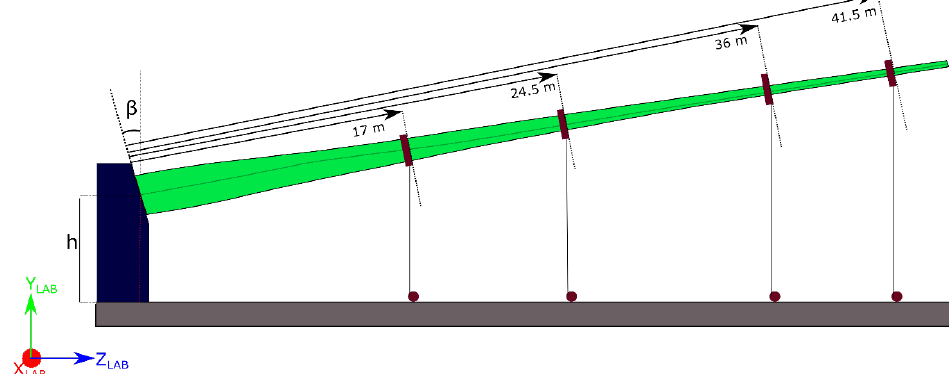
Figure 1. Schematic overview of the static test setup. The blade was positioned onto the reaction block at a height (h) of approx. 4.5 m at an angle of 13 deg. The lab coordinate system was positioned as indicated. Different load cases were created by mounting the blade onto the test stand under a different pitch angle. Loads were introduced by means of four fixtures mounted on the blade at distances of 17 m, 24.5 m, 36 m, and 41.5 m from the root.